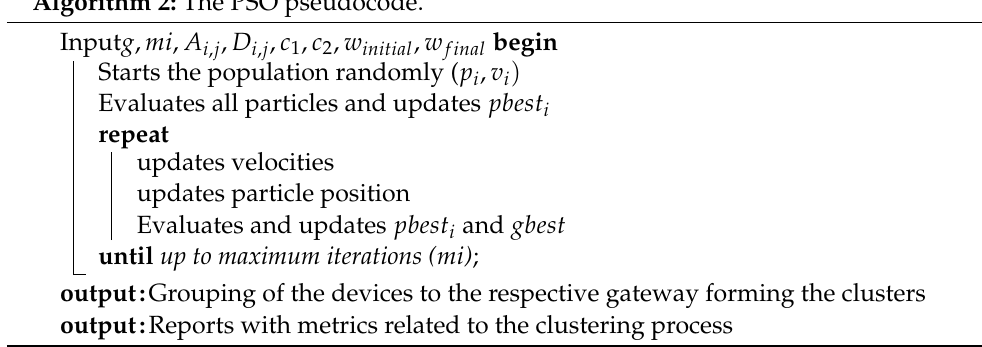
Algorithm 2: The PSO pseudocode.